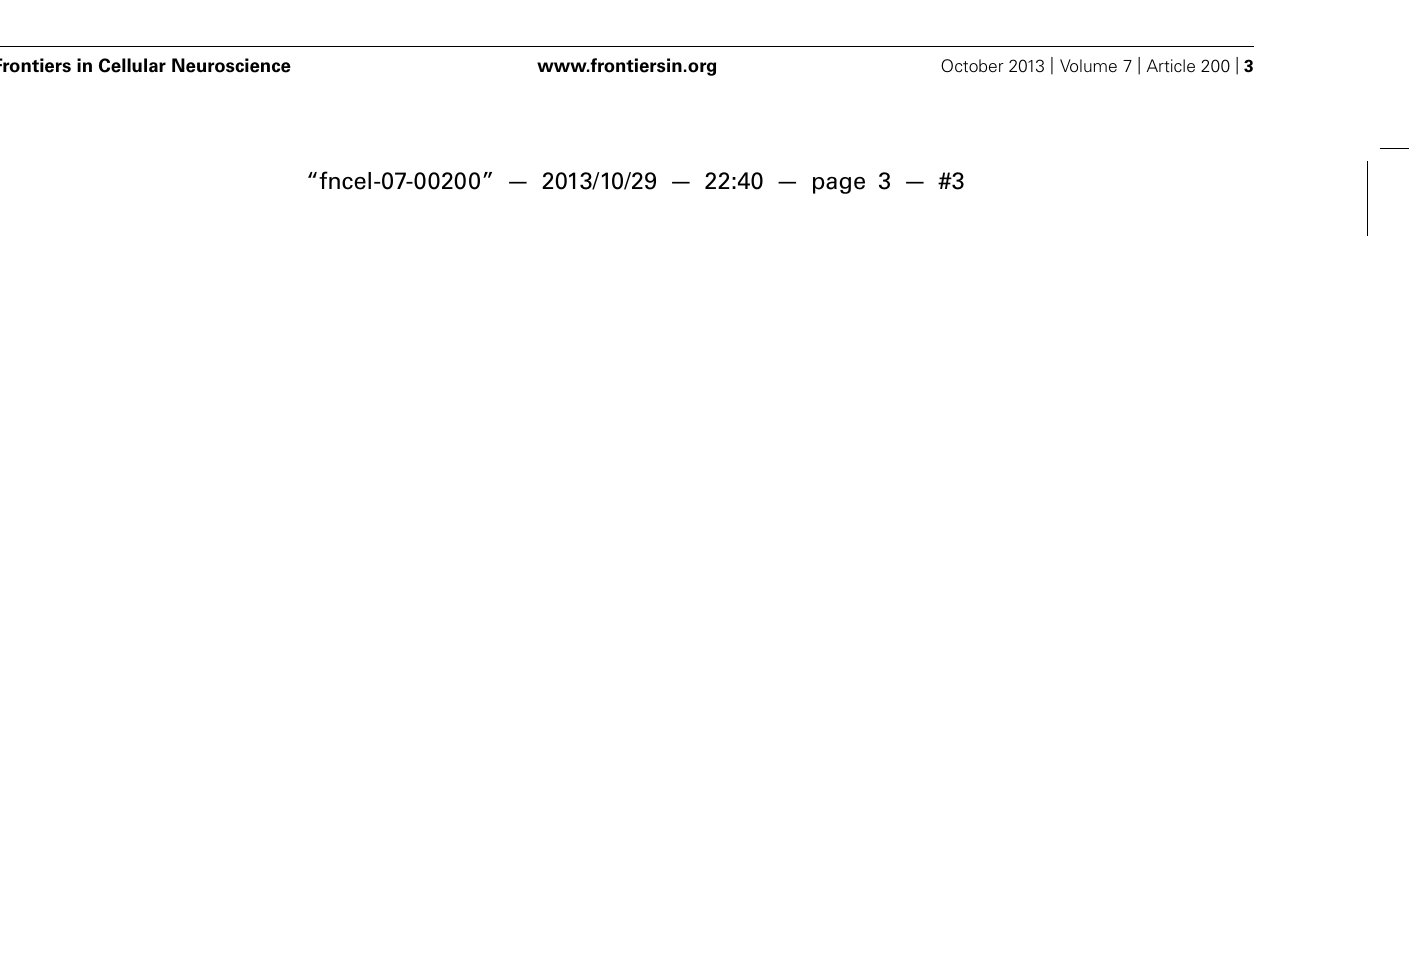
The most rostral group can be subdivided by the presence or absence of the homeodomain genes Engrailed 1 and 2 (En1/2). (C) Next to the position related programming differences (B) more disperse transcription factors dependence (Pet1) and 5-HT subset markers exist in the 5-HT neuronal